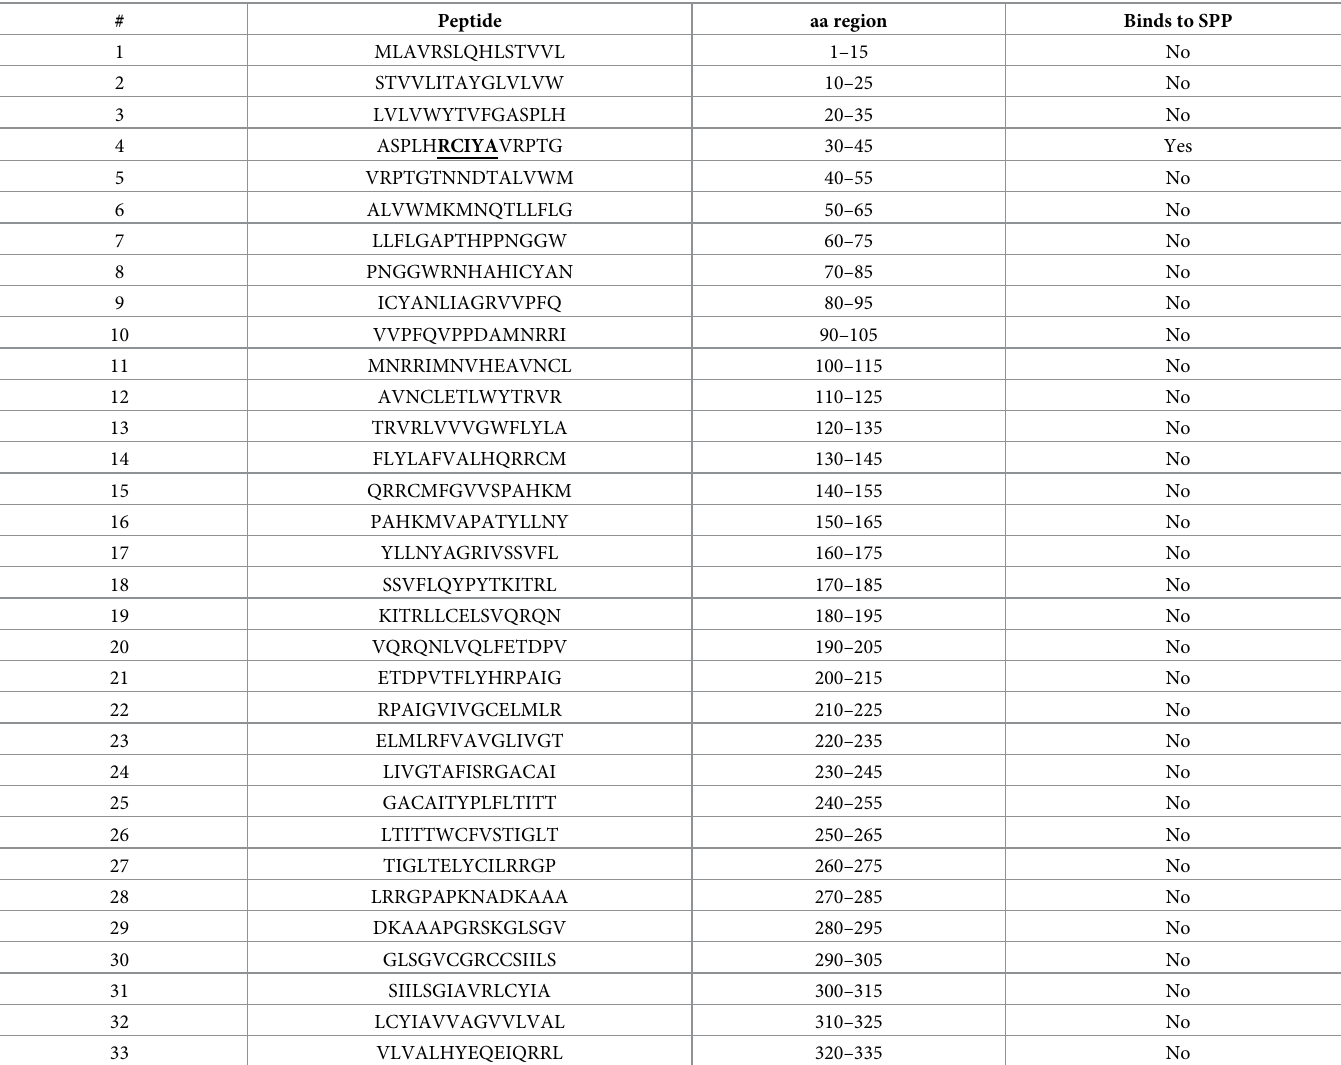
Table 1. Fine mapping of the gK binding region to SPP using gK synthetic peptides a